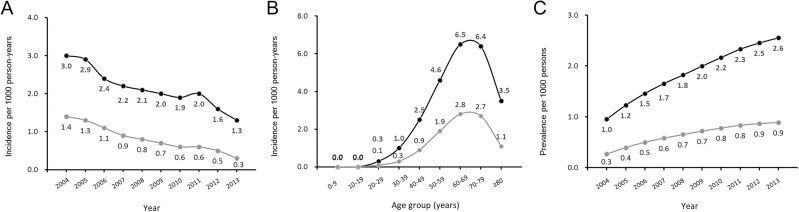
Incidence and Prevalence of Clinically Diagnosed Pterygium in South Korea.(A) Incidences of pterygium (black dot and lines) and surgically removed pterygium (gray dot and lines) per 1,000 person-years according to year. (B) Incidences per 1,000 person-years according to age group and (C) prevalence (%) according to year.